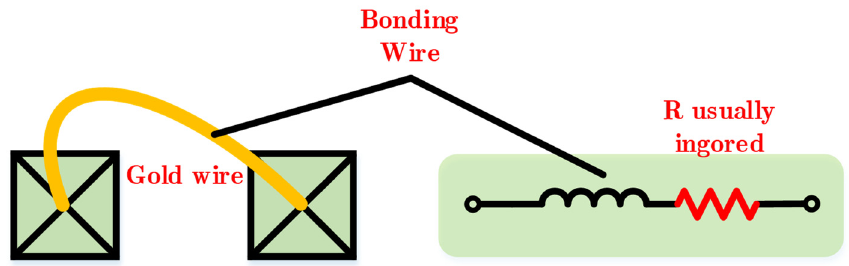
Figure 5. The model of the bonding wire.